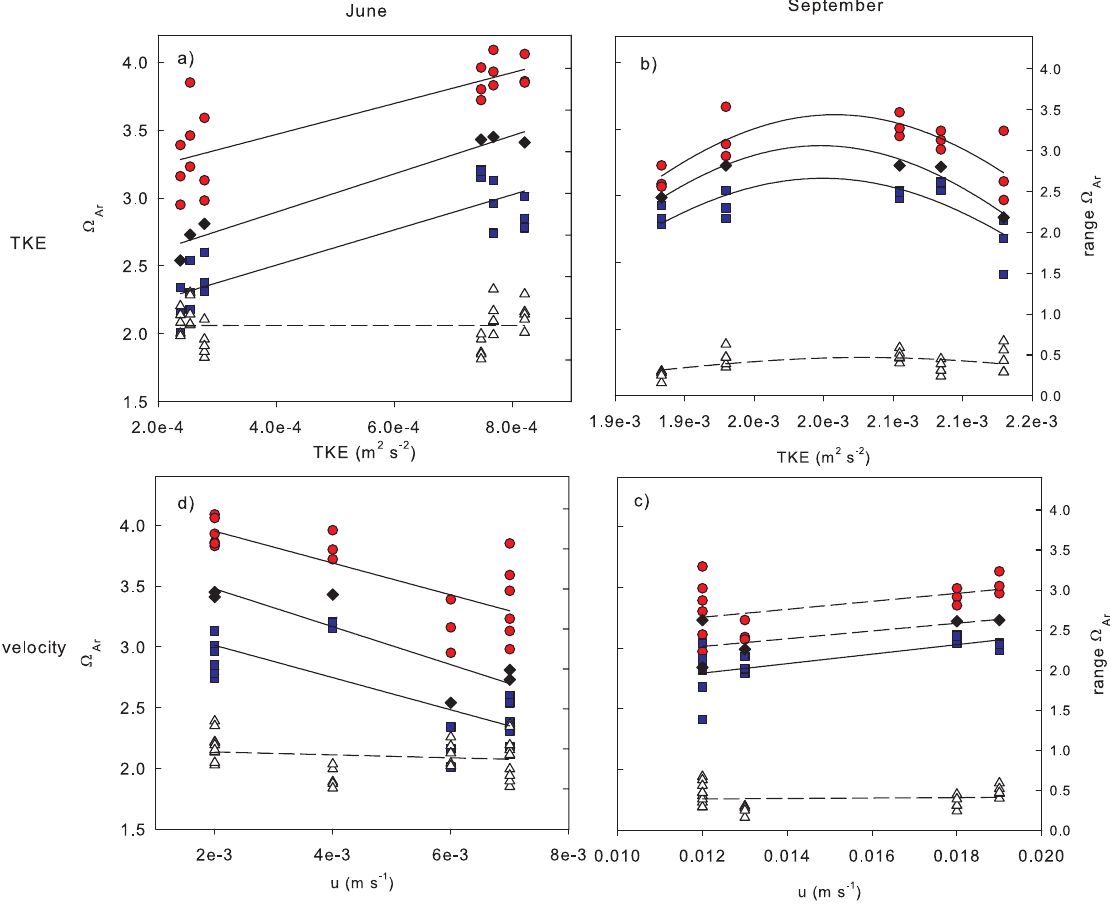
Fig. 5. The relationship between (a) , (b) TKE (m 2 s − 2 ) and (c) , (d) u (ms − 1 ) and max, mean, min and the range of (cid:127) Ar . Non- significant relationships are dotted lines. Regressions are linear ( y = ax + b ), except fo TKE in September, where they are peak models −√ ((x − x 0 )/b) 2 ) Maximum (cid:127) ( y = a Ar is represented with red circles, Mean (cid:127) Ar are black diamonds, Minimum (cid:127) Ar are blue squares while the range of (cid:127) Ar (right y-axis) are white triangles.